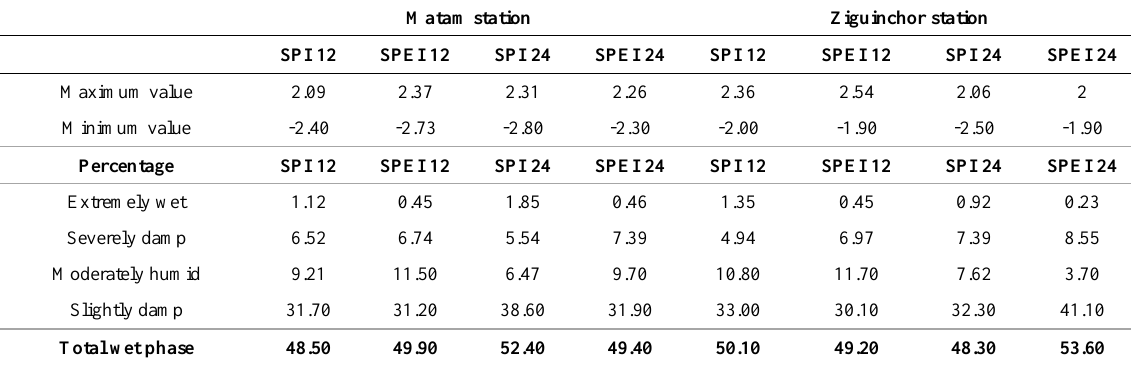
Table 3. Characteristics of the stations in Matam (in the Senegal River valley) and Ziguinchor (in the Casamance basin) selected in the study areas Matam